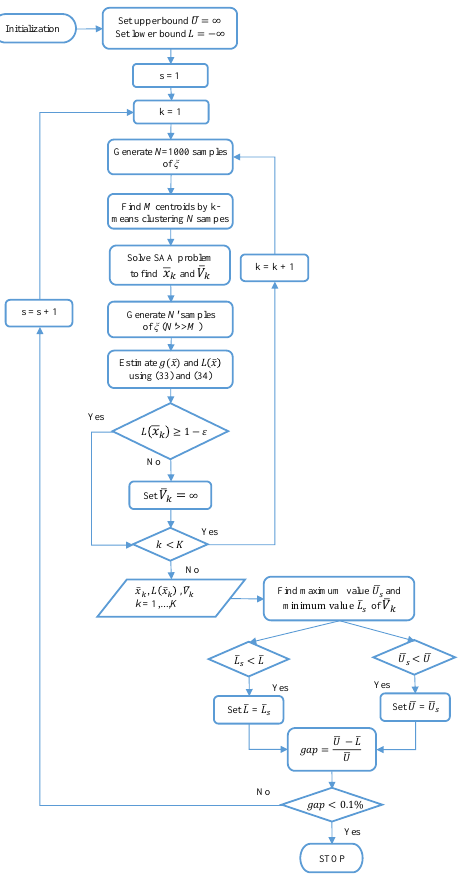
Figure 5. Flow chart of the Modified Sample Average Approximation (MSAA) algorithm.